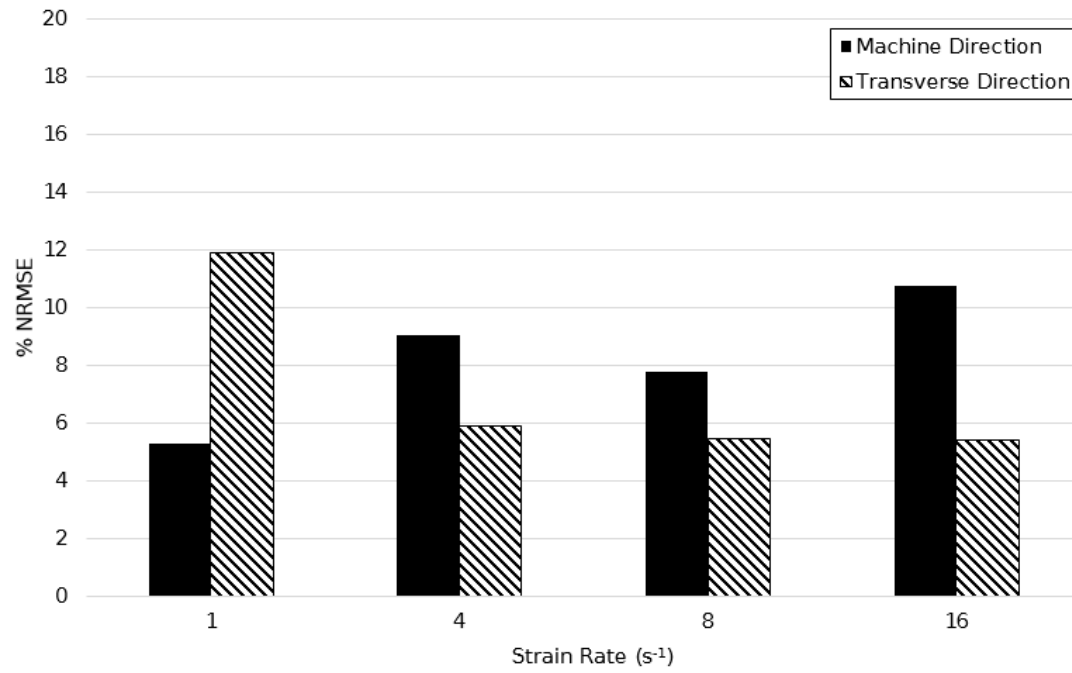
Figure 24. Normalised root mean squared error between simulated and experimentally observed stress–strain behaviour between strain rates of 1–16 s − 1 at a temperature of 130 °C.